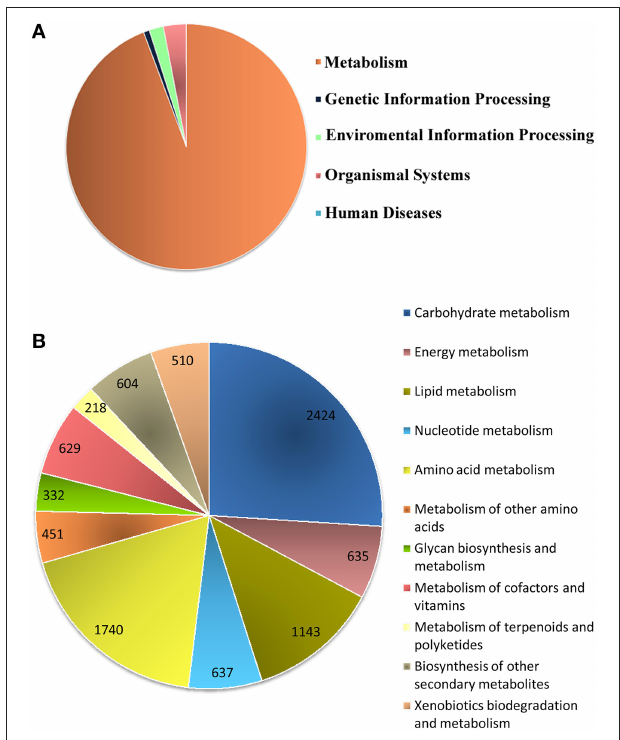
FIGURE 5 | Annotation of P. amarus unitranscripts by KEGG database. (A) Distribution of P. amarus unitranscripts into KEGG biological categories. (B) Classification of P. amarus leaf transcriptome into KEGG “Metabolism”